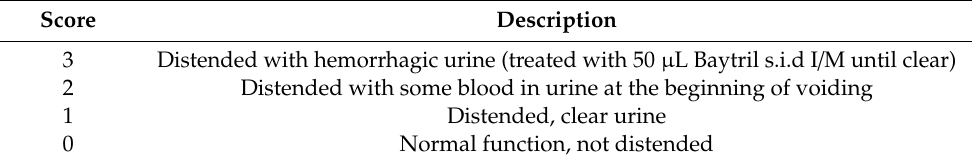
Table 4. Urinary bladder dysfunction score